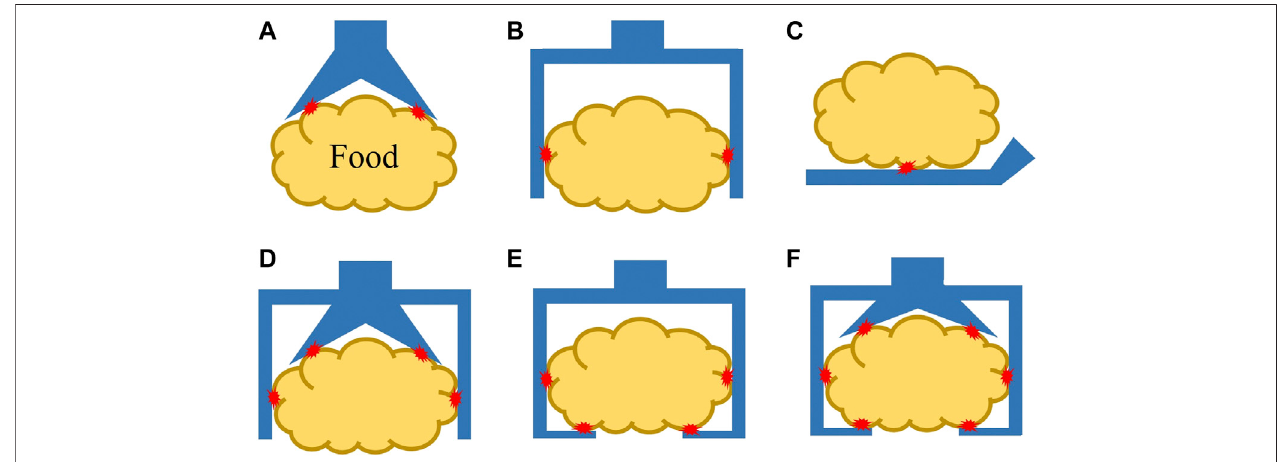
FIGURE 3 | Different types of robotic end-effectors according to their handling positions at (A) top surface, (B) side surface, (C) bottom surface, (D) top and side surfaces, (E) side and bottom surfaces, and (F) top, side, and bottom surfaces. Red star marks indicate contact positions.